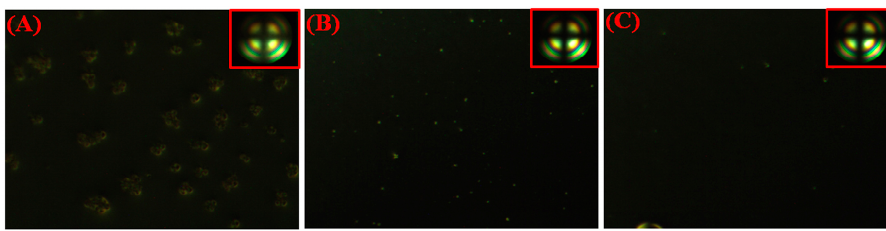
Figure 2. Polarizing optical microscope (POM) microphotographs of LC cells with 2 wt % DA monomers ( A ), 1 wt % DA monomers ( B ), and 0.5 wt % DA monomers ( C ) after UV irradiation.